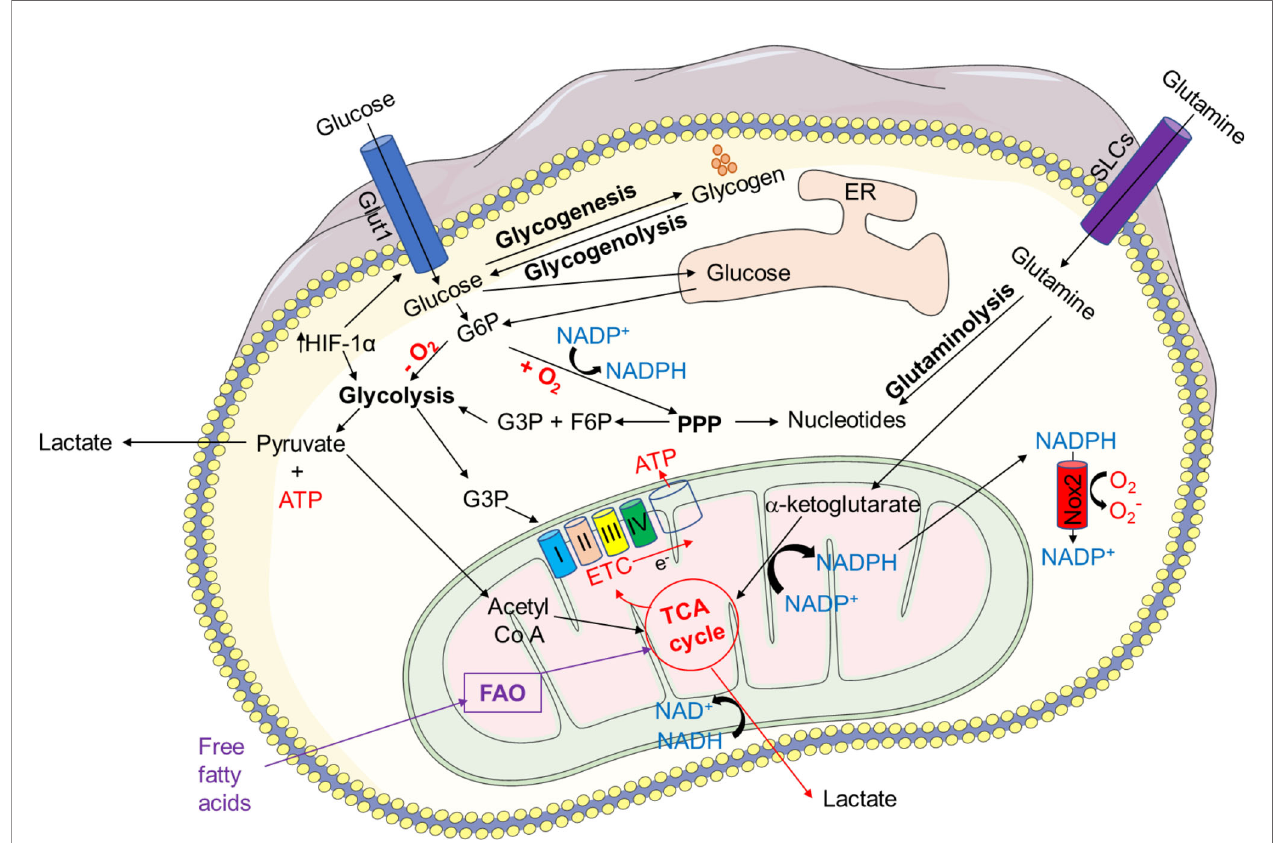
FIGURE 1 | Overview of key metabolic pathways in neutrophils. In neutrophil cytosol, glycolysis is a primary metabolic route that transforms glucose to pyruvate via a number of enzymes and reactions. Pyruvate is converted to lactate and released out of the cells during anaerobic glycolysis in absence of oxygen. Pyruvate contributes to the TCA cycle after conversion to acetyl-coenzyme A (acetyl Co A) in the presence of oxygen, which results in reducing energy intermediates NADH and dihydro fl avine-adenine dinucleotide (FADH2) to generate ATP via the electron transport chain (ETC). Neutrophils also use the pentose-phosphate pathway (PPP) to generate NADPH and riboses, which are then used to build nucleotides, by employing glucose-6-phosphate, a glycolytic pathway intermediate, as an entry point during the oxidative and non-oxidative phases to manufacture NADPH and riboses. NADPH modulates redox signaling and is required for NADPH oxidase- dependent ROS production in neutrophils. Glycogen reserves become concentrated in neutrophils when glucose levels rise, providing glucose-based glycolytic intermediate supply on demand. Through fatty acid synthesis (FAS), the TCA cycle intermediate citrate can be converted to free fatty acids, which can then be transported from the extracellular environment through the FAO pathway to produce acetyl-CoA, which fuels the TCA cycle and produces signi fi cantly more energy in the form of ATP. Glutamine helps the TCA cycle by producing a -ketoglutarate through glutaminolysis. Neutrophils also use the glycerol-3-phosphate shuttle to create NAD + from NADH, which aids in mitochondrial membrane potential. HIF-1 a augments the activity and expression of GLUT1 and GLUT3, resulting in increased glucose uptake, elevated hexokinase 2 (HK2) and phosphofructokinase B3 (PFKFB3) enzymatic activities, and enhanced ATP